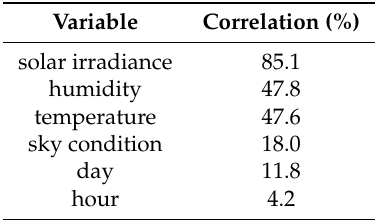
Table 1. Correlation of variables with photovoltaic (PV) generation.